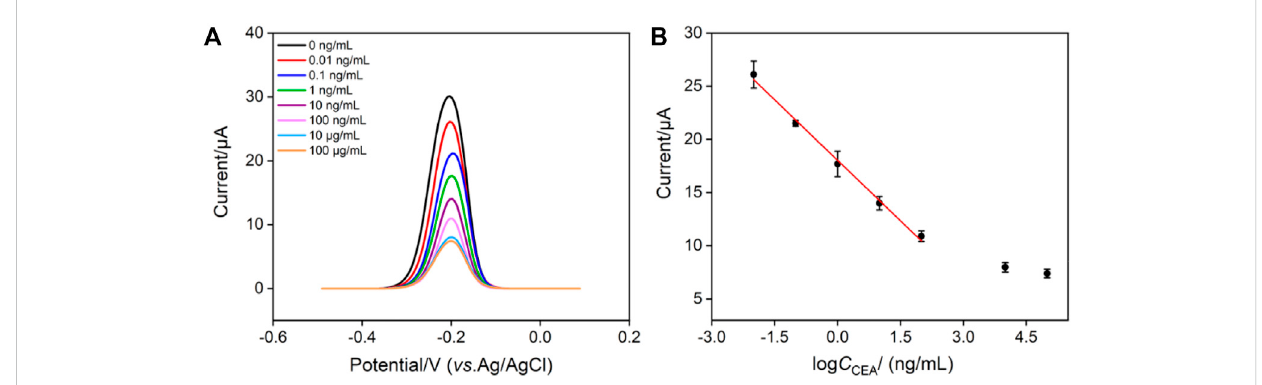
FIGURE 6 (A) DPVresponseoftheimmunosensortodifferentconcentrationsofCEAfrom0.01 ng/mLto100 μ g/mL. (B) CalibrationcurveoftheproposedEC immunosensor. Error bars represent the relative standard deviation (RSD) of three measurements.